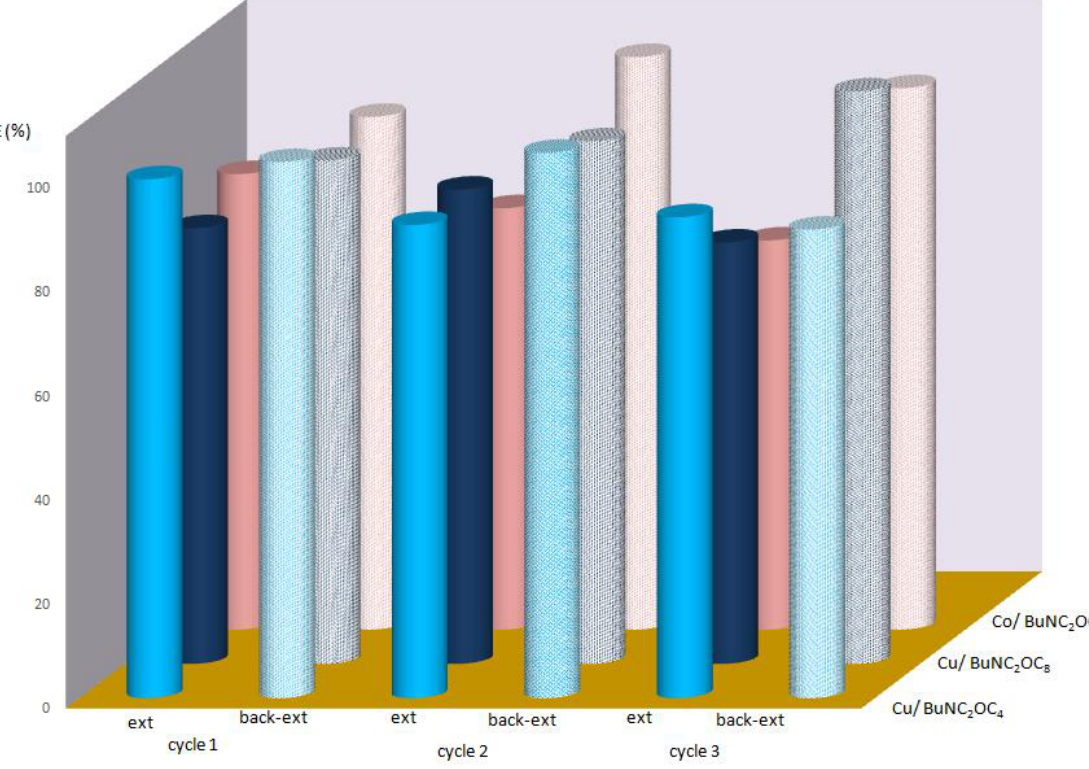
Figure 9. Reusability of ionic liquid phase for copper and cobalt extraction using BuNC 2 OC n -Clsal.